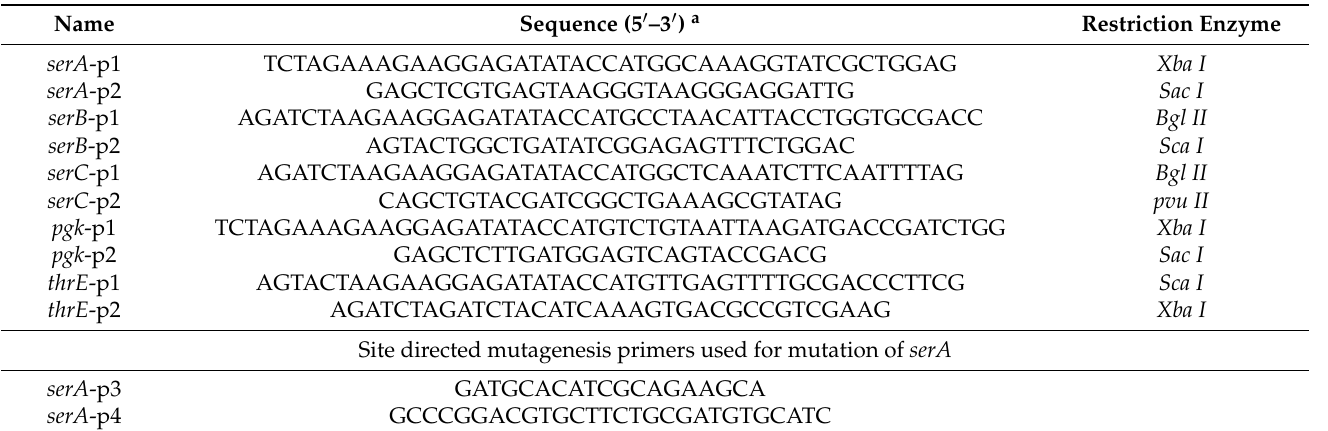
Table 3. The primers used in the